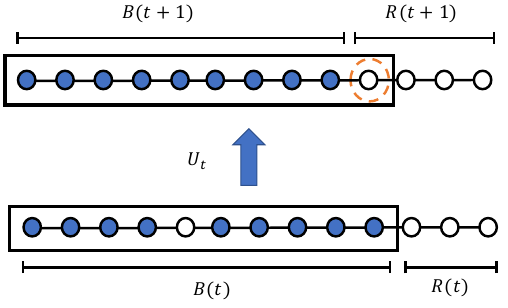
Figure 8 . Microscopic void formation processes in which operators with non-trivial support some- where in B ( t ) evolve to operators trivial at one site in B ( t +1) , which becomes part of the Hawking radiation at time t + 1 . Such processes contribute to the second term in